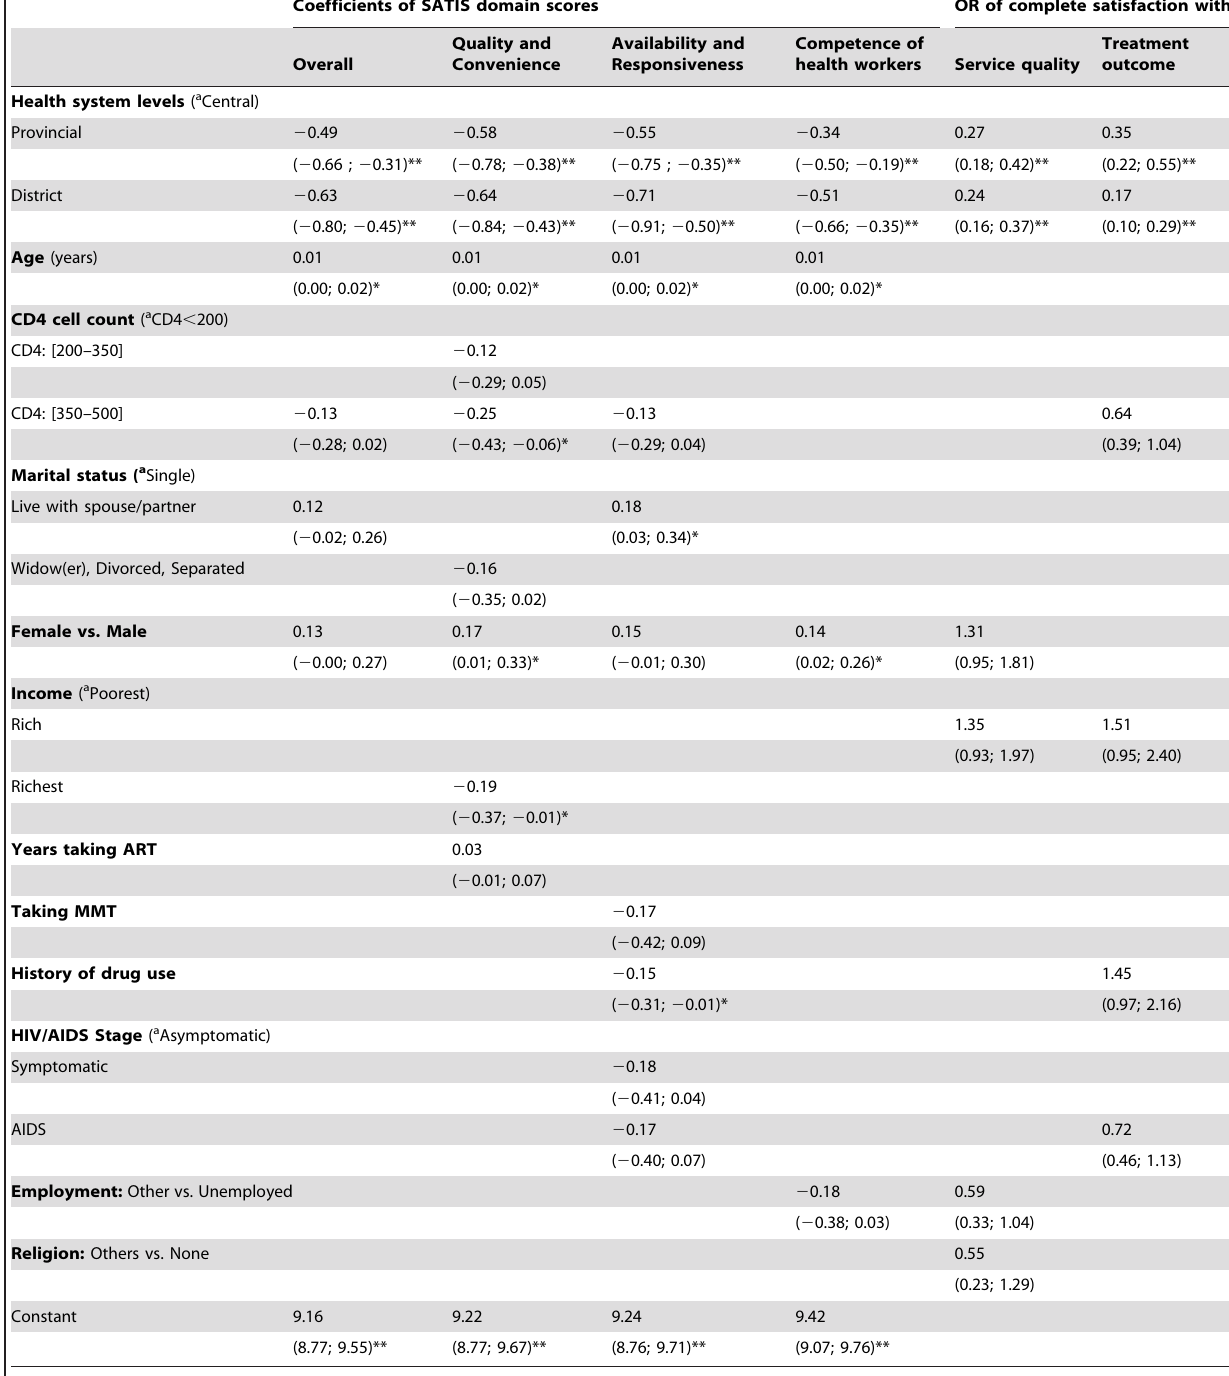
Table 3. Factors associated with Patient satisfaction with HIV/AIDS